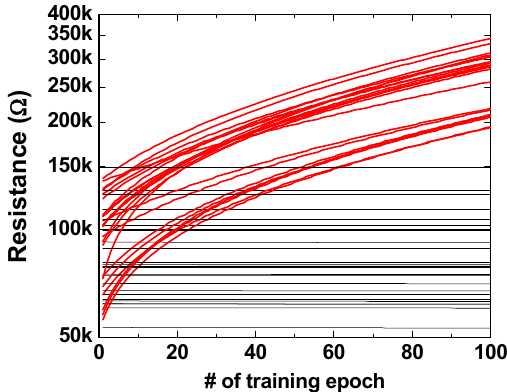
Figure 10. Resistance change of the negative memristors as a function of training epochs.